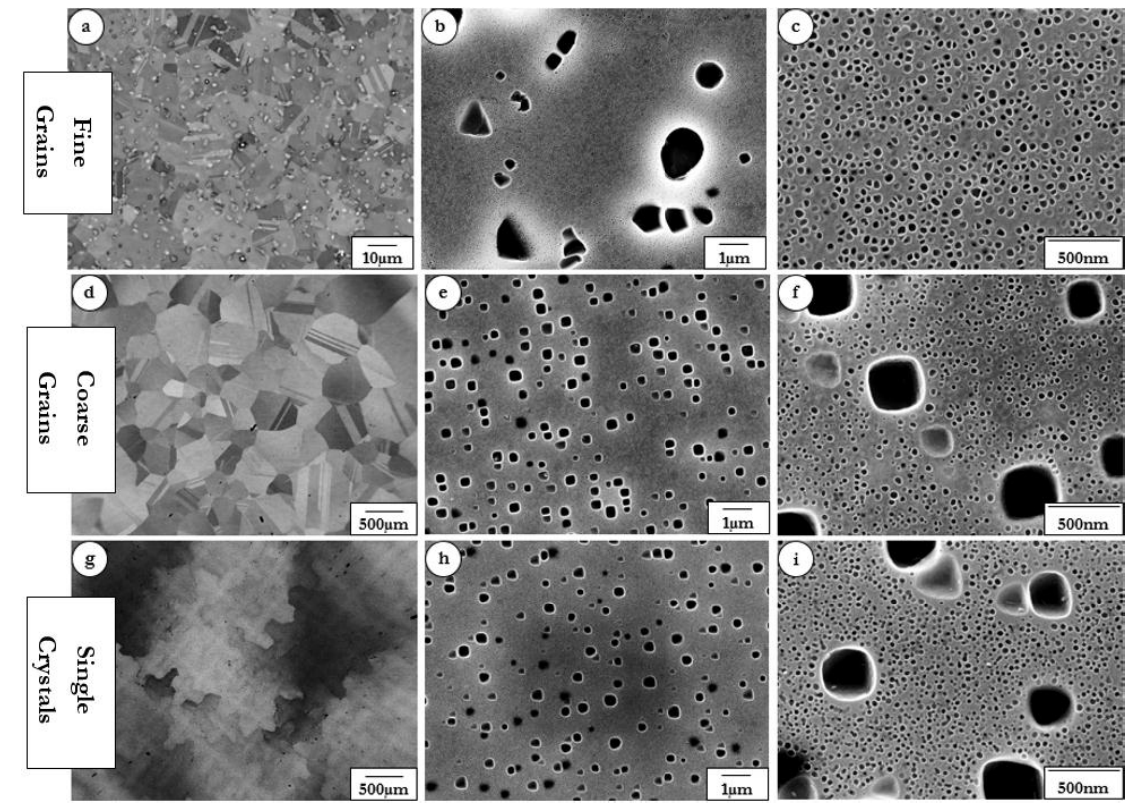
Figure 1. Granular microstructure observed in SEM back-scattered electron mode ( a , d , g ), and coarse and fine γ’ precipitation ( b , e , h and c , f , i respectively) observed using the secondary electron mode for the fine grains microstructure ( a , b , c ), coarse grains microstructure ( d , e , f ) and the single crystals microstructure ( g , h , i ). Note that boundaries observed in ( g ) correspond to low angle boundaries (crystallographic misorientation less than three degrees between each